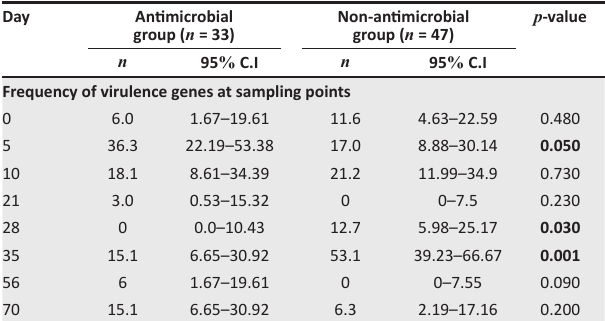
TABLE 3a: Frequency of Escherichia coli isolates, virulence genes, adhesion factors and pathotypes from Escherichia coli isolates with virulence genes. Day Antimicrobial group ( n =